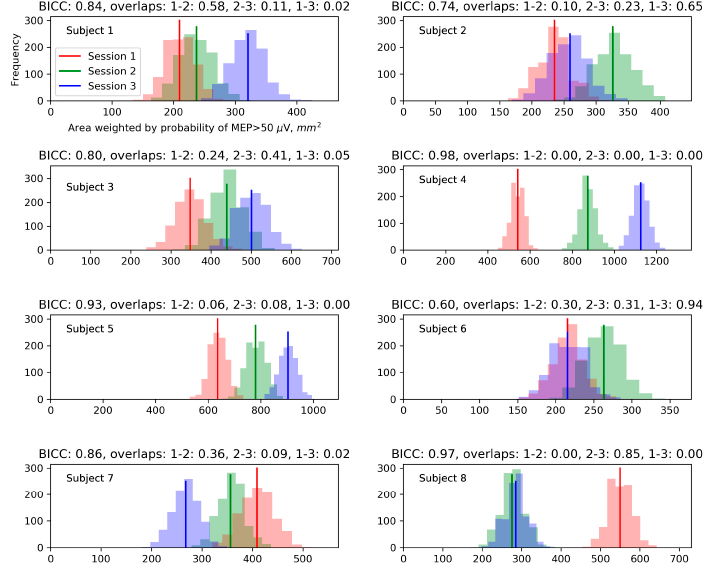
Figure 6. Comparison of the between-session and within-session variability for the probability-weighted area (sum of grid cell areas multiplied by the probabilities of suprathreshold MEPs in them). Each plot corresponds to one subject and shows three histograms for different mapping sessions. Each histogram shows the within-session distribution of the values of the probability-weighted area obtained from 1000 maps generated by bootstrapping from a given map. Above the plots, the measures of the possibility to discriminate between sessions are shown: the bootstrapping-based between-session intraclass correlation coefficient (BICC) and the pairwise distribution overlaps.